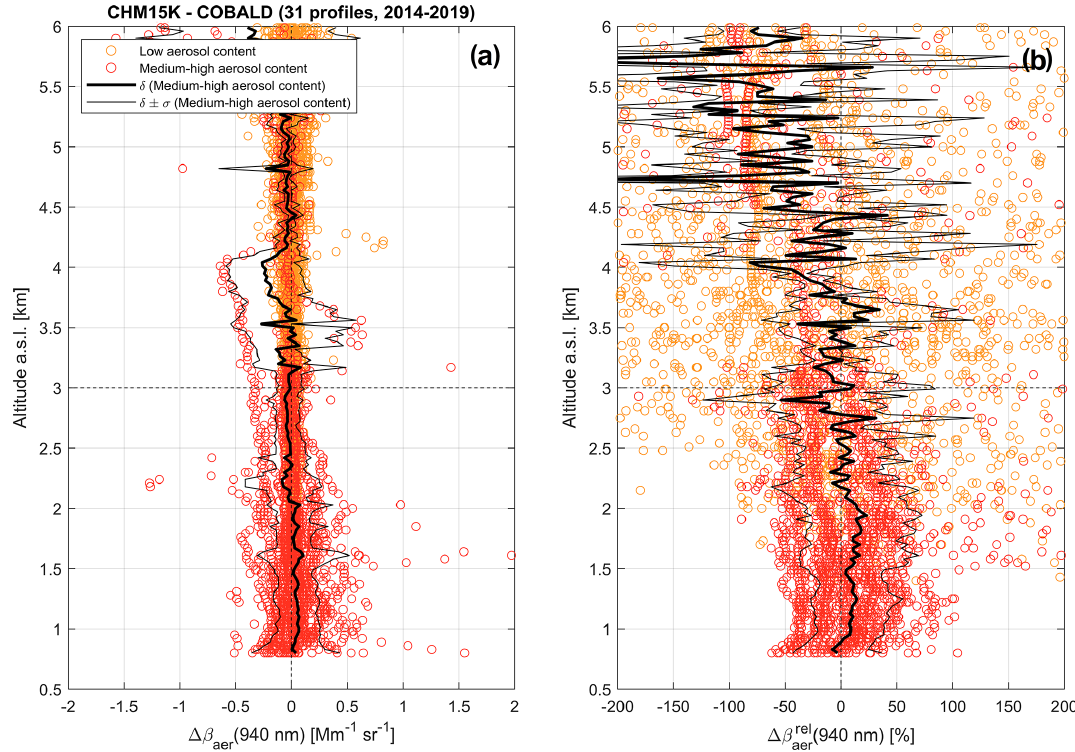
Figure 8. Statistical comparison of CHM15K vs. COBALD: vertical profiles. Panel (a) : all medium-high-aerosol-content (red circles) and low-aerosol-content (orange circles) data points of CHM15K − COBALD aerosol backscatter coefficient difference ( (cid:49)β aer ) at 940nm as a function of altitude. Panel (b) : same as panel (a) , with (cid:49)β aer expressed in percent units (%) relative to the COBALD measurements (i.e., (cid:49)β rel aer ). Mean deviation ( δ ) and mean ± standard deviation ( δ ± σ ) profiles are shown in both panels by thick solid and thin dashed black lines, respectively. The 3km altitude level is highlighted by a thin dashed black